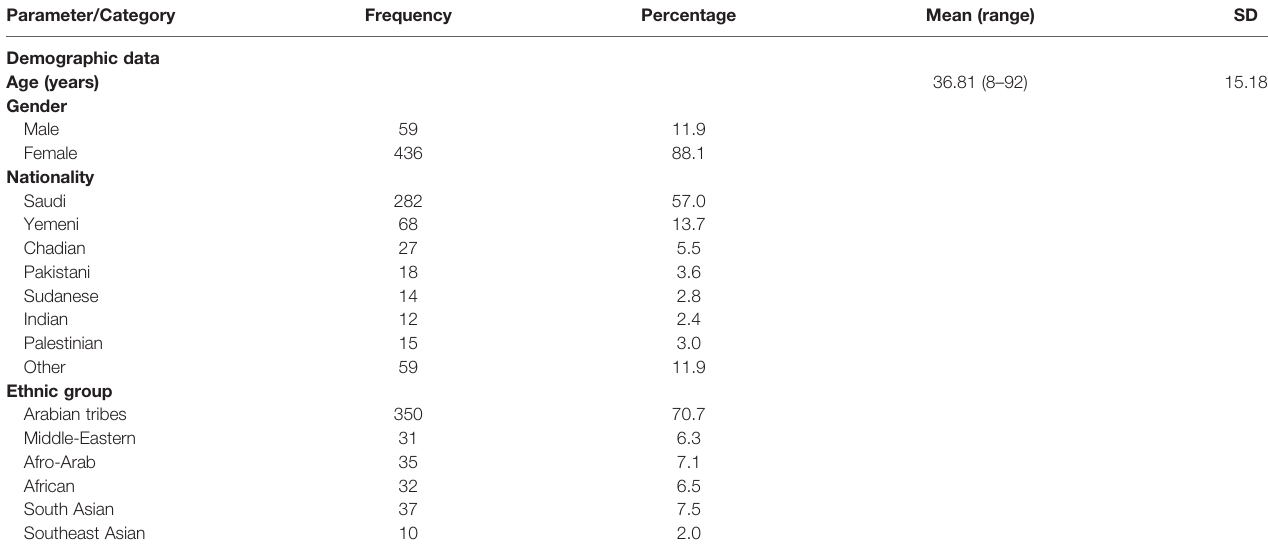
TABLE 1 | Participants ’ demographic characteristics and nonspeci fi c biological